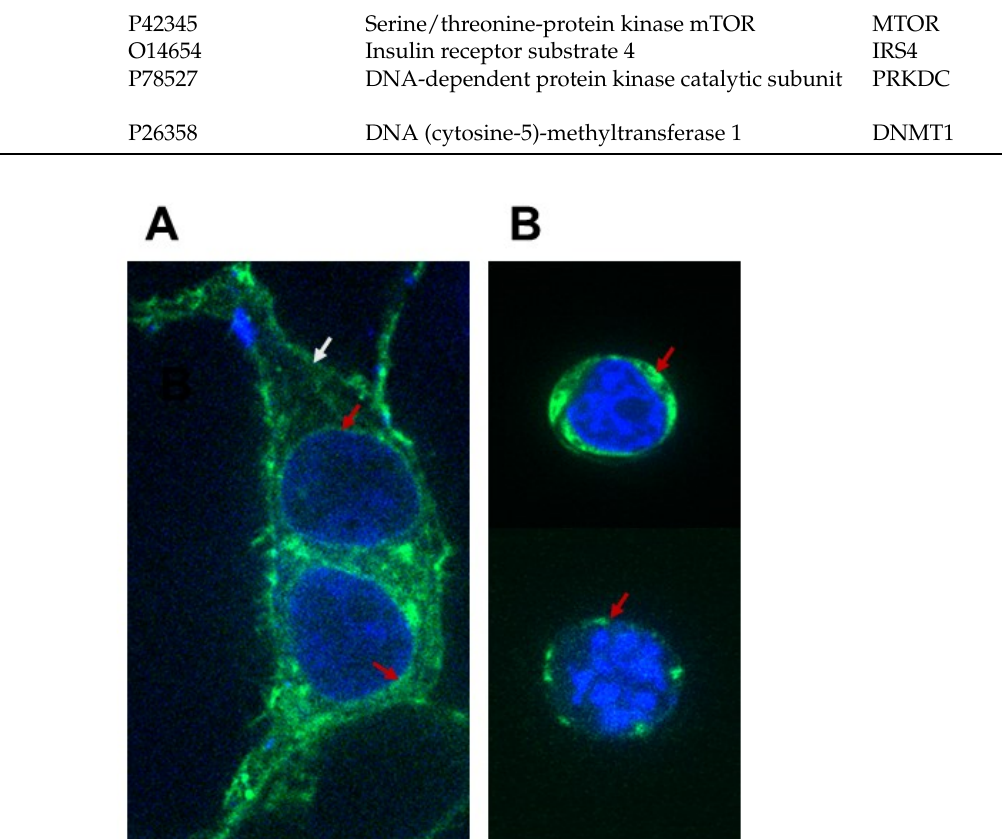
Figure 3. GPR37L1 protein has a nuclear localization signal. Nuclear localization signal (NLS) and immunoblots showing the expression of GPR37L1 in the nucleus. ( A ) Amino acid sequence of GPR37L1 showing the potential bipartite (underlined) and classical monopartite (bold) NLS